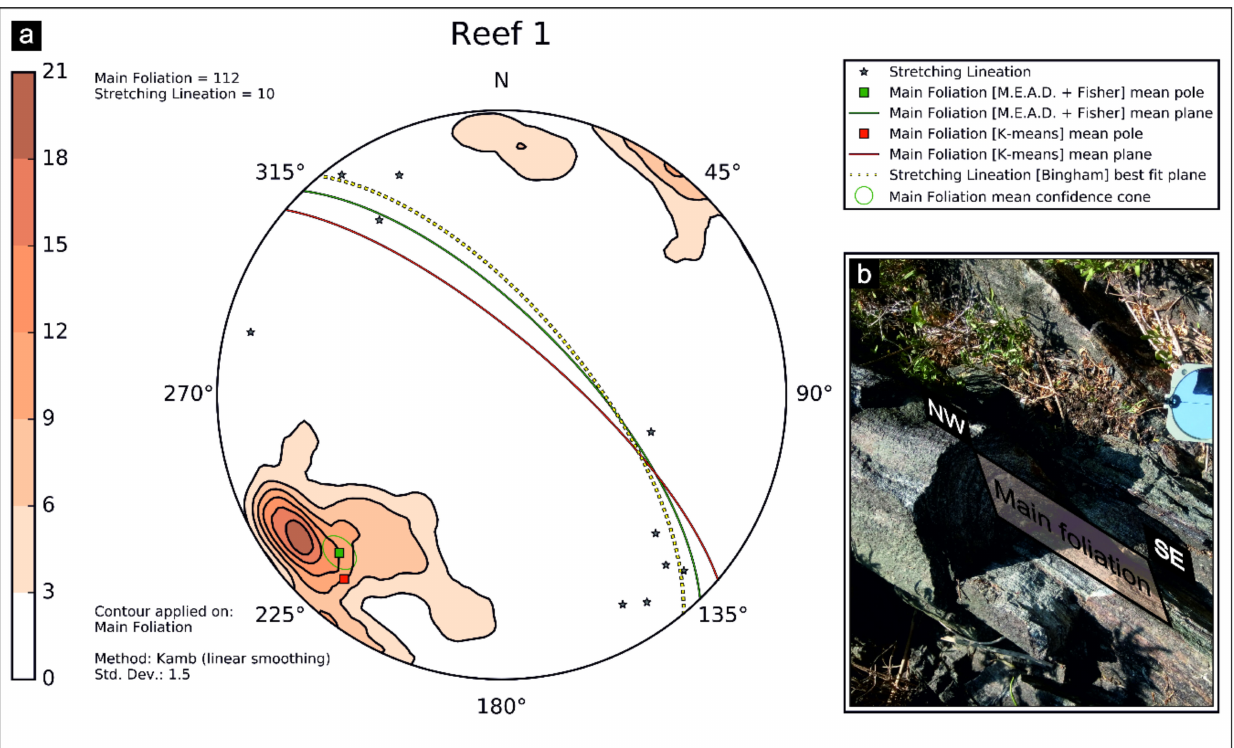
Figure 13. ‘Reef 1 (cid:48) station: ( a ) equal-area azimuthal projection and statistical analysis of main foliations and stretching lineations data and ( b ) field example of isoclinally folded foliation in mylonites (tonalites interlayered with paragneisses). The ASN log file is provided in Appendix B (Table